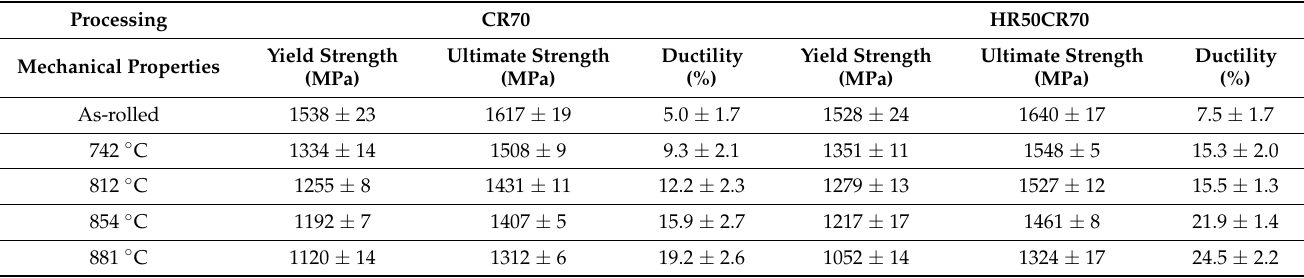
Figure 7. The mechanical tensile stress–strain curves of CR70 and HR50CR70 Ti 65 (AlCrNbV) 28 Zr 7 MEAs with different annealing temperatures. Table 4. Tensile mechanical properties of Ti 65 (AlVCrNb) 28 Zr 7 MEAs with different TMT parame- ters.